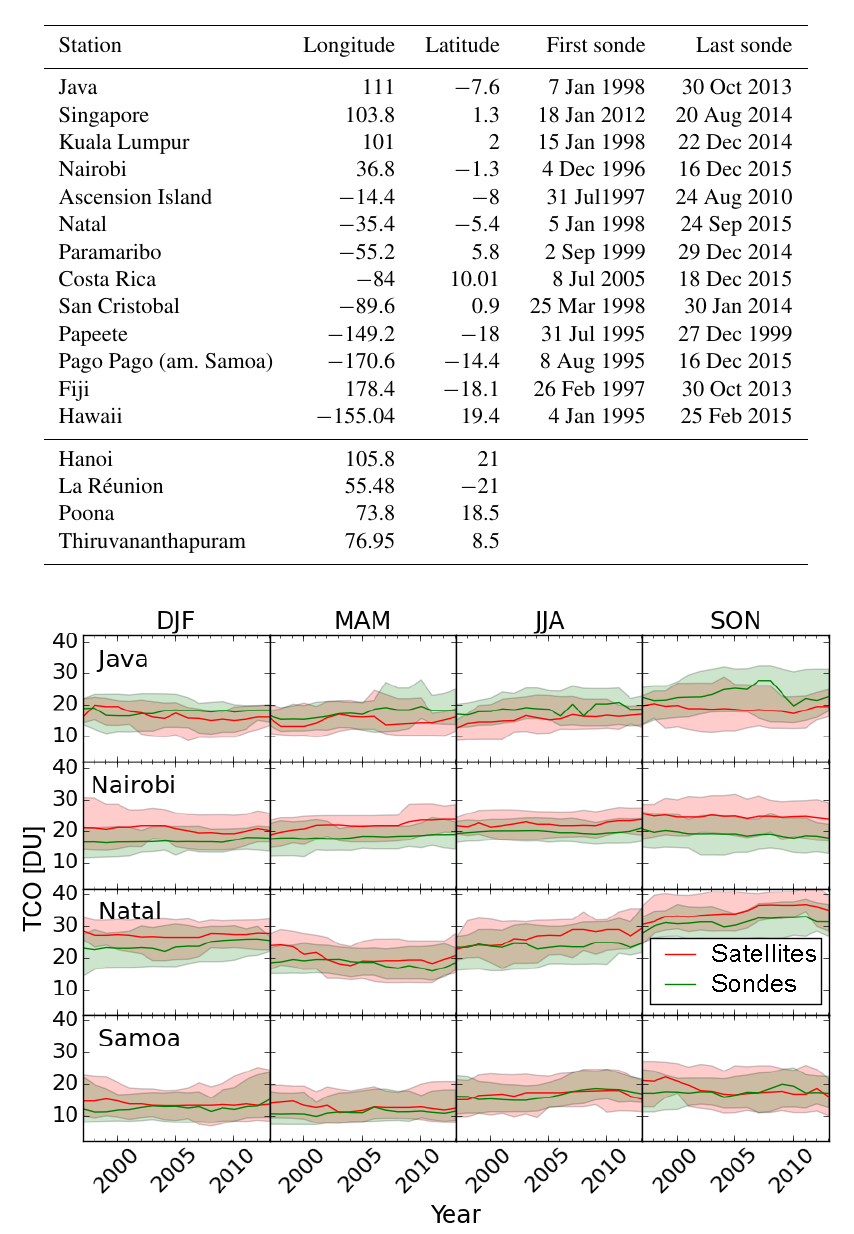
Table 2. SHADOZ and WOUDC stations used for the comparison with the satellite-retrieved tropospheric columns. The first and last sondes included in the comparison are also listed, for 2015 only data from five stations are available. Two of the stations at the end of the table, are too close to the edges of the tropics; therefore they were not considered in the general comparison. The Indian sondes in Poona and Thiruvananthapuram were skipped because we were not sure about the data quality. However, they are mentioned for completeness.